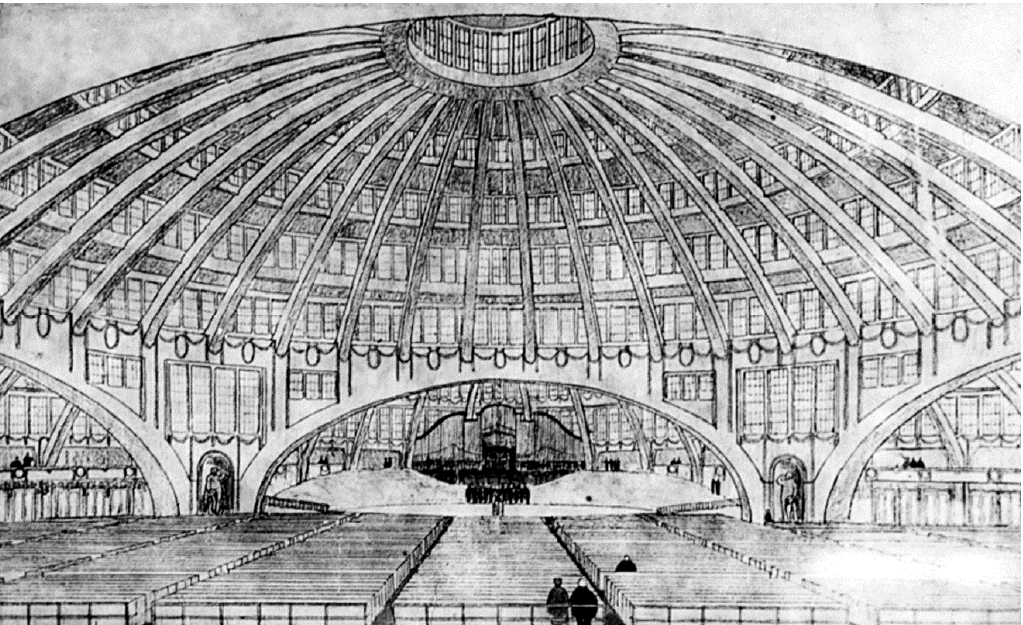
Figure 9. Design of the Centennial Hall interior by Max Berg, around 1910; a reproduction from a slide used by Berg for his lectures at the beginning of 1911 (National Museum in Wrocław).